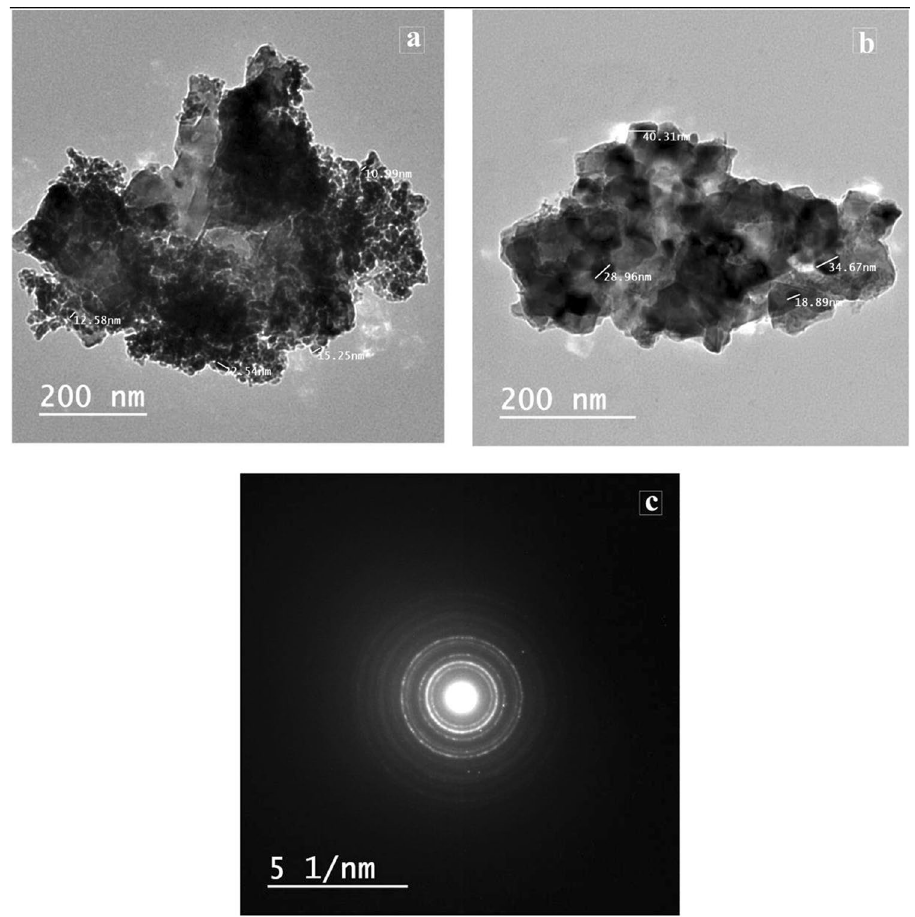
Figure 2. HR-TEM and SAED micrographs of of MnFe 2 O 4 nanoparticles.